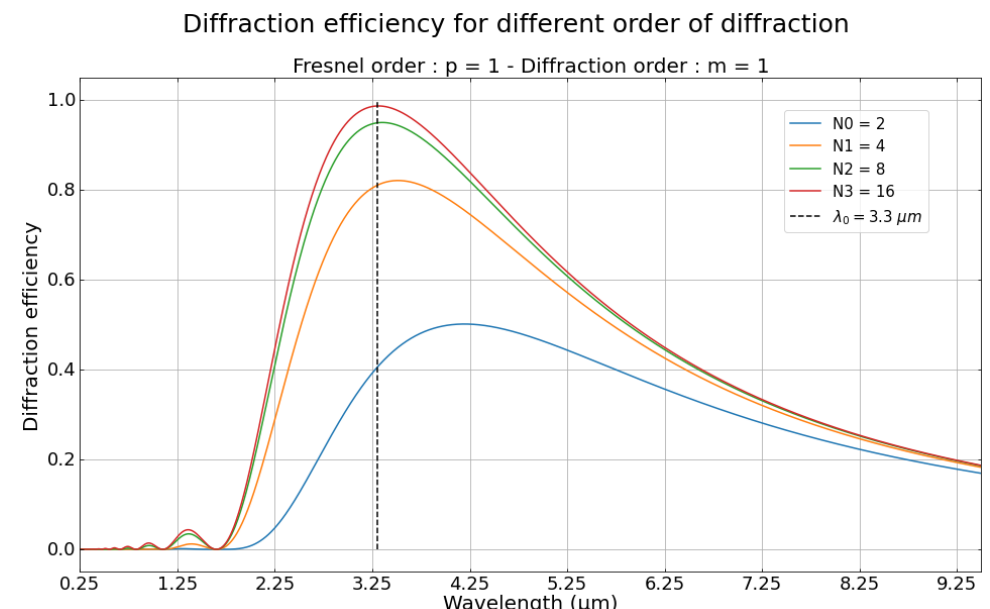
Figure 4. Graphic representation of the diffraction efficiency as a function of the wavelength for the designed first-order Fresnel lens at wavelength 3.3 µm. Only the diffraction efficiency of the first order of diffraction is shown. The different colors represent the different discretization levels. The dashed line represents the central wavelength of this design.